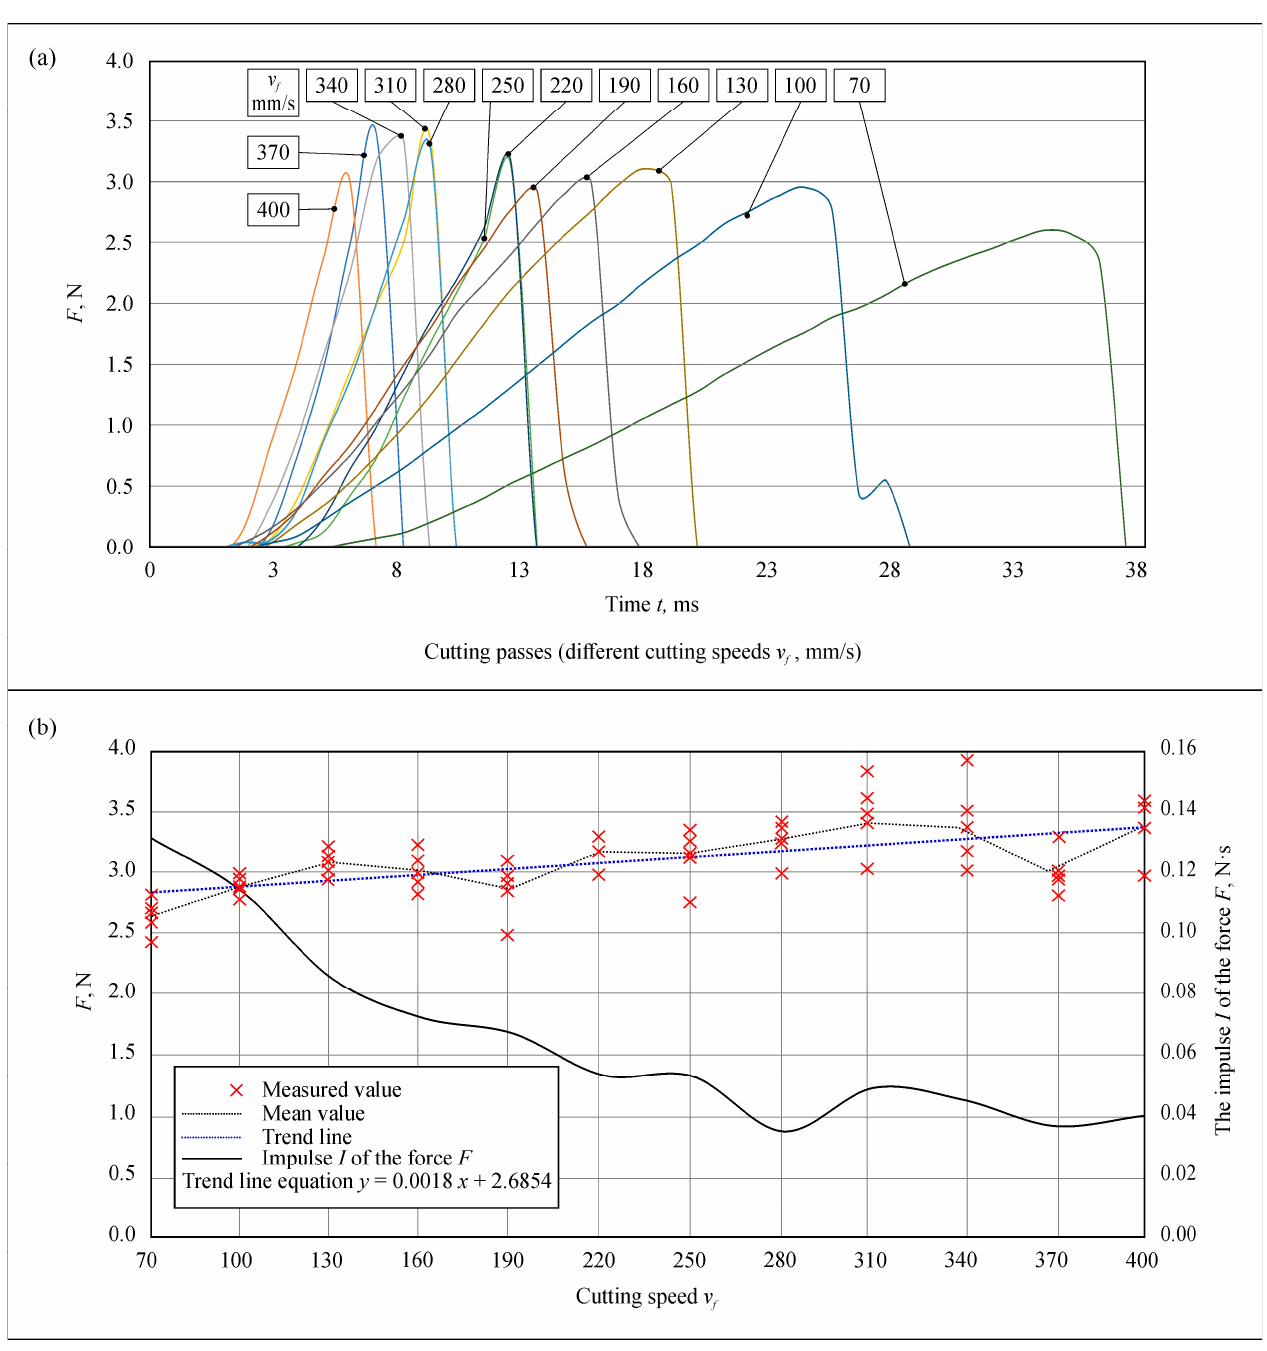
Figure 6. Experimental results of cutting force F relative to cutting speed: ( a ) averaged cutting force curves for each cutting speed; ( b ) measured values of cutting force, mean values, and the impulse I of force F .